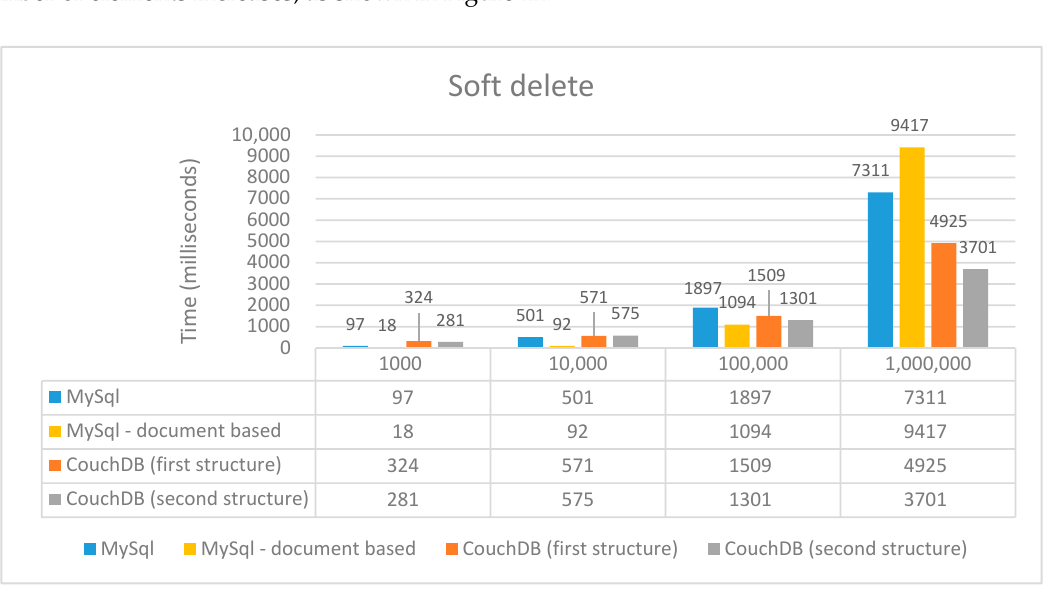
Figure 12. Performance time (ms) for soft delete.